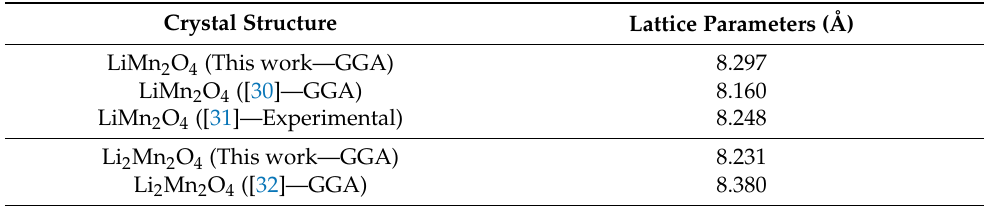
Table 1. Lattice parameters of cubic spinel LiMn 2 O 4 .